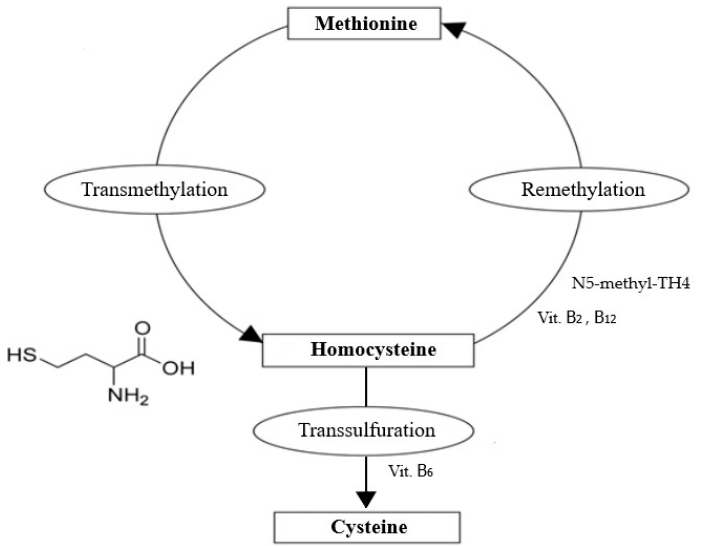
Figure 1. Schematic overview of homocysteine (Hcy) metabolism. Hcy is exclusively derived from dietary methionine. It can be catabolised via a transsulfuration pathway to cysteine or remethylated to methionine. Vitamins of the B-group (vit. B6; pyridoxine, vit. B2; riboflavin, vit. B12; cobalamin and biologically active form of vit. B9, N5-methyl-tetrahydrofolate (N5-methyl-TH4) play a crucial role in this pathway.